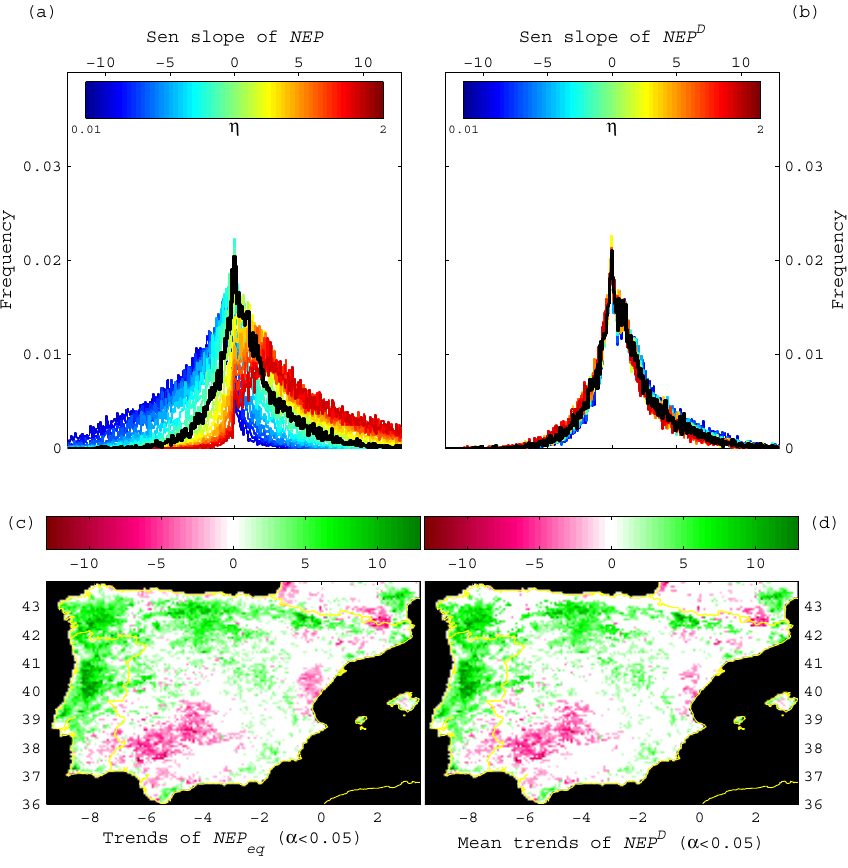
Fig. 7. The distribution of the NEP trends (Sen slopes, gCm − 2 yr − 2 ) is strongly dependent on η values (a) while for NEP D its distribution appears invariant with η (b) . The spatial pattern of the significant NEP trends for equilibrium conditions (c) only slightly differs from the mean trends for NEP D (d) . Per pixel, an NEP D trend is only considered significant when for all η used in the simulation the significance level is systematically lower than 0.05 and the trend’s signal is consistent (always positive or always negative). The trend is then calculated as the mean of NEP D time series for all η s. Any slope trend is only considered positive or negative when its absolute value is at least 1.5gCm − 2 yr − 2 .